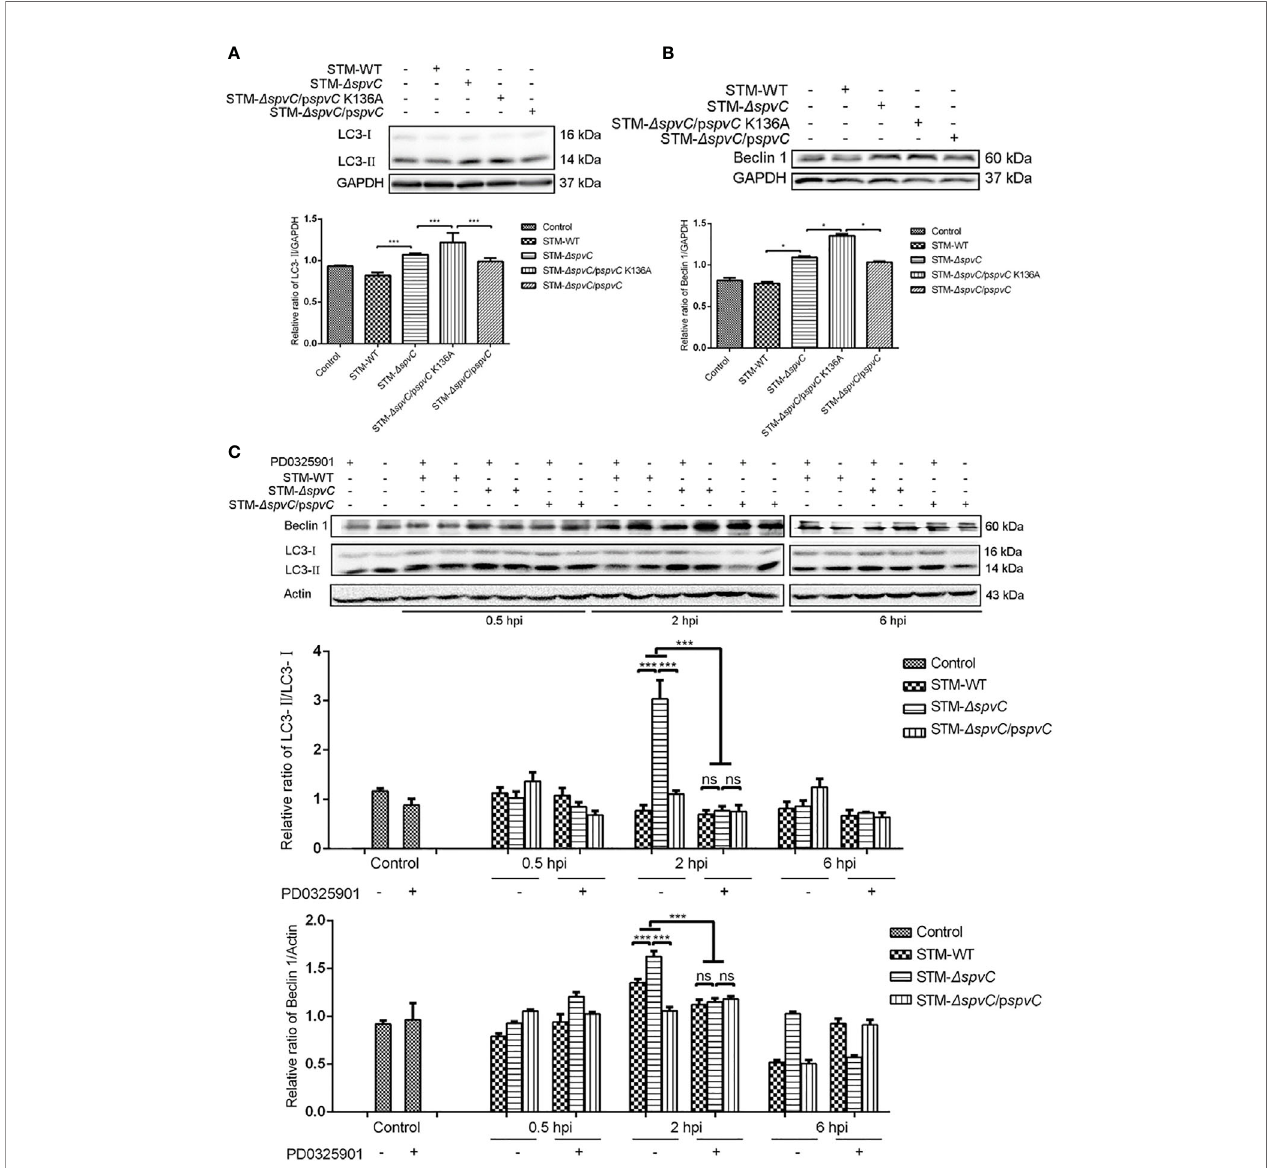
FIGURE 3 | SpvC phosphothreonine lyase activity is critical for inhibiting autophagy in Salmonella Typhimurium infection. (A, B) J774A.1 cells were infected with STM- WT, STM- D spvC , STM- D spvC /p spvC or STM- D spvC /p spvC K136A at an MOI of 10 for 2 h. Cell lysates were analysed by western blot with speci fi c antibodies to LC3 (A) , Beclin 1 (B) and the control GAPDH. (C) HeLa cells were infected with STM-WT, STM- D spvC or STM- D spvC /p spvC at an MOI of 100 after being pretreated with PD0325901. Cell lysates were analysed by western blot with speci fi c antibodies to LC3, Beclin 1 and the control Actin at 0.5 hpi, 2 hpi and 6 hpi. Data were compared by ANOVA. Values are expressed as the means ± S.D., n = 3. Statistically signi fi cant differences are indicated. *** P < 0.001; * P < 0.01; ns, not signi fi